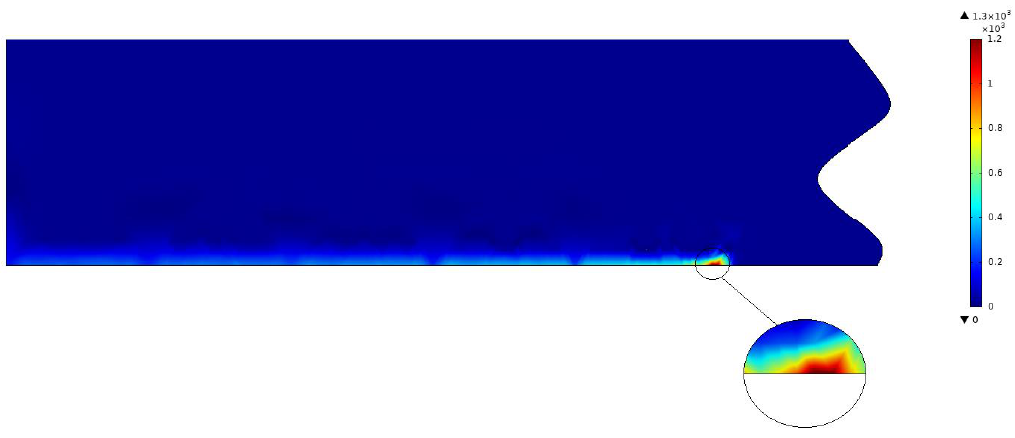
Figure 6. Transient temperature cloud at 1 s of W18Cr4V cutting.